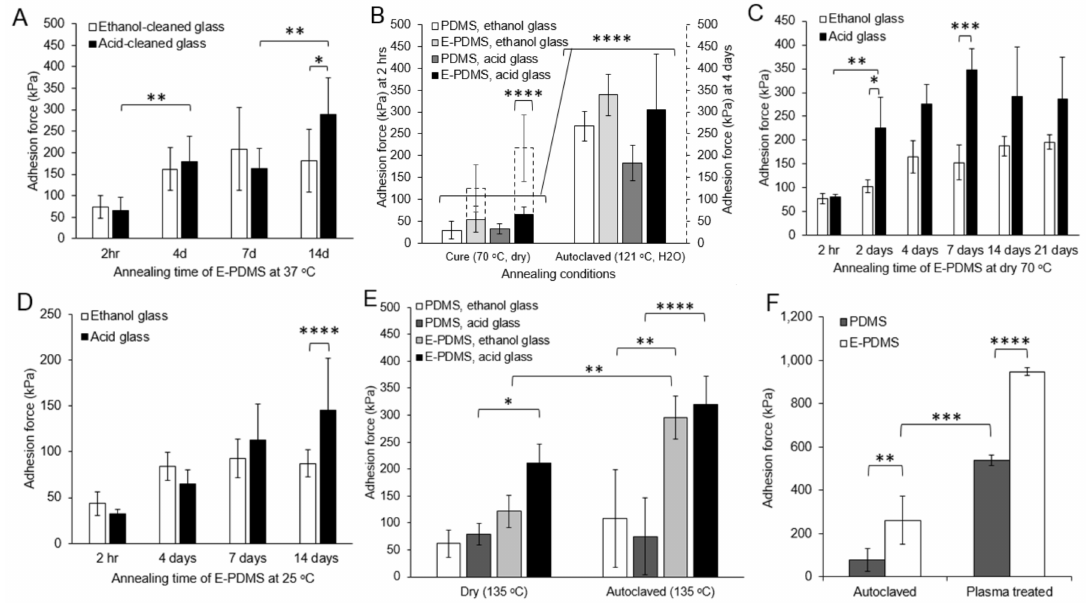
Figure 3. Measurements of removal forces for annealed E-PDMS and PDMS plugs. ( A ) Forces required to remove annealed (humidified 37 ◦ C) E-PDMS plugs off microscope slides were measured. Similar increases in E-PDMS adhesion results are achieved for both ethanol- and acid-cleaned glass at 37 ◦ C. ( B ) Significant temporal effects of two annealing conditions were tested for both PDMS and E-PDMS plugs on ethanol-cleaned glass (white and light grey bars) and acid-cleaned glass (dark grey and black bars) after 2 h processing time. E-PDMS annealed to ethanol- and acid-cleaned glass with dry heat (4 days, dashed bars, secondary y -axis) has a significant increase of removal forces over 2 h for E-PDMS on ethanol- and acid-cleaned glass. Autoclave annealing produces superior bonding forces that are statistically significant over dry heat for 2 h and 4 days. ( C ) Temporal-dependence of annealing E-PDMS with 70 ◦ C dry heat measured with greater temporal detail from dashed and solid bars of B. Significant differences are noted between acid- and ethanol-cleaned glass and between 2 h and 2 days and at 14 days. ( D ) E-PDMS plugs kept at ambient temperature (25 ◦ C) and humidity show increased removal forces over a two-week period. ( E ) Measurements of high-temperature- matched annealing (135 ◦ C) under dry or humidified conditions show that heat, humidity, and E-PDMS produce the highest bonding forces. ( F ) Comparison of extraction by autoclave annealing to extraction by plasma-heat annealing. E-PDMS outperforms PDMS in both cases (one-way ANOVA). ( A – E ) Two-way ANOVA. p values for differences are indicated by asterisks p ≤ 0.05 (*), p ≤ 0.01 (**), p ≤ 0.001 (***), p ≤ 0.0001